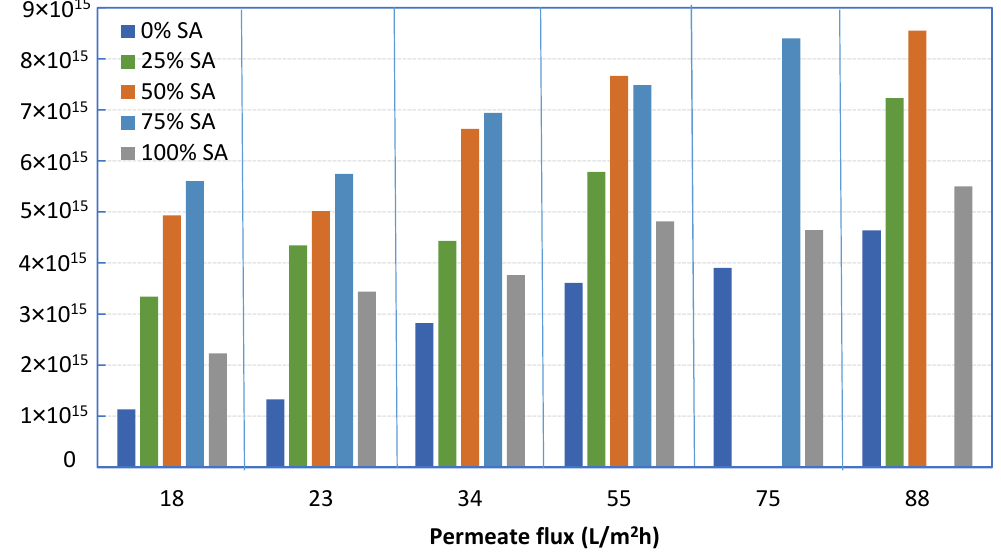
Figure 5. Initial fouling resistance α i values, for various foulant compositions and fluxes .